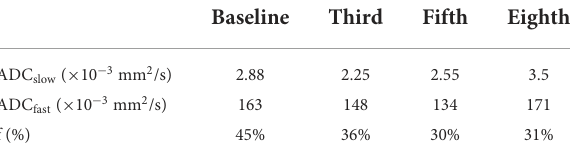
TABLE 2 IVIM parameters at the baseline and after the third, fifth, and eighth chemotherapy